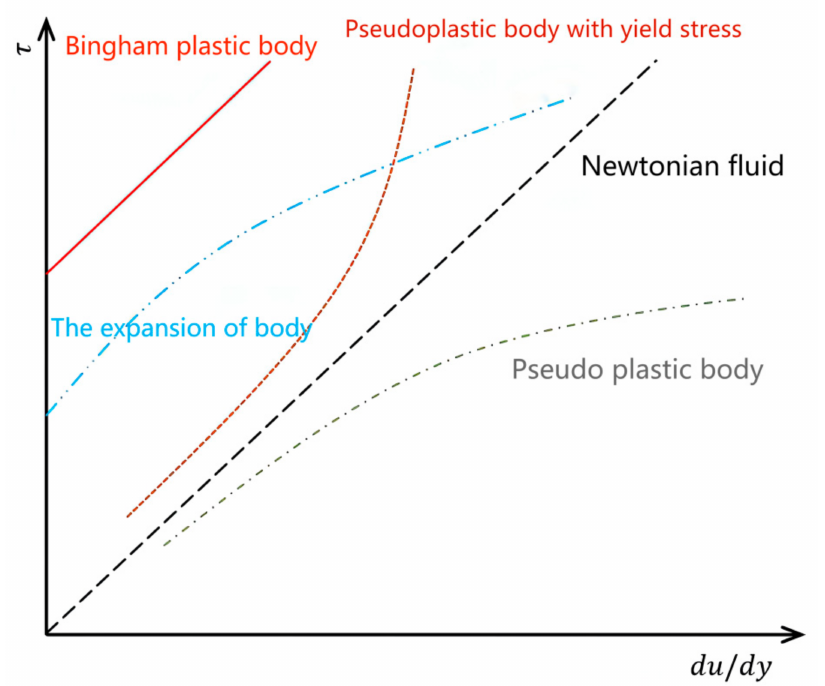
Figure 1. (Source elaborated by authors based on [20]). Rheological model of solid–liquid two- phase